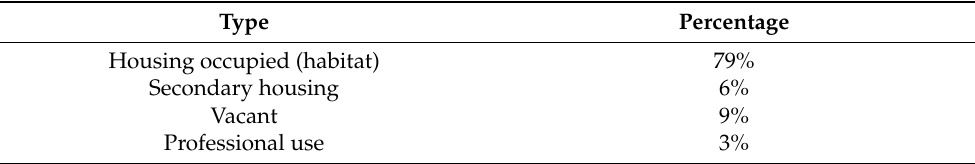
Table 6. Distribution of houses in Morocco according to the 2014 census. Type Percentage Housing occupied (habitat) 79% Secondary housing 6% Vacant 9% Professional use 3%